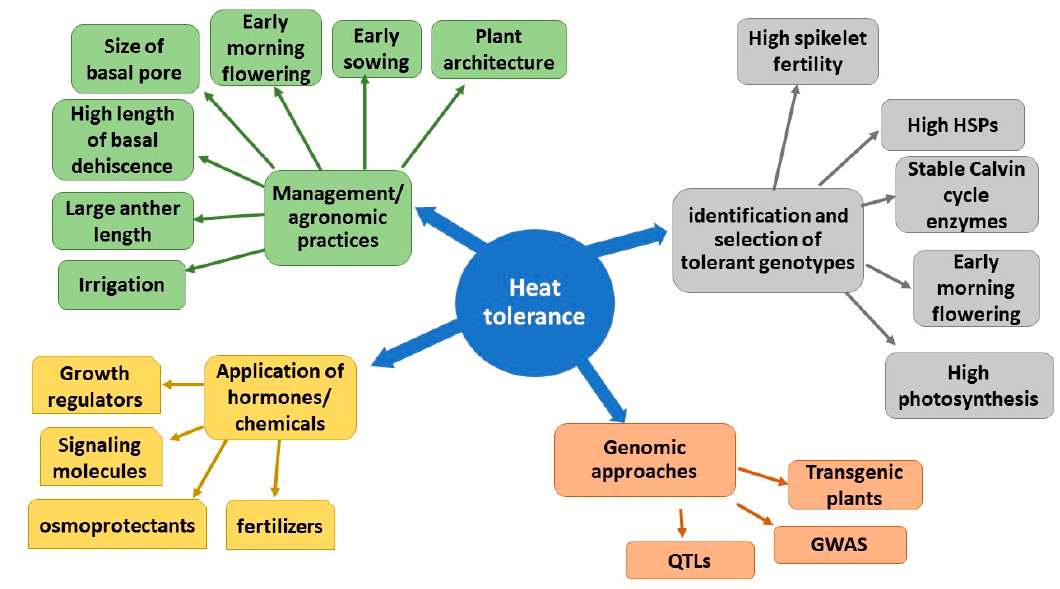
Figure 1. Various approaches to improve heat tolerance in rice.